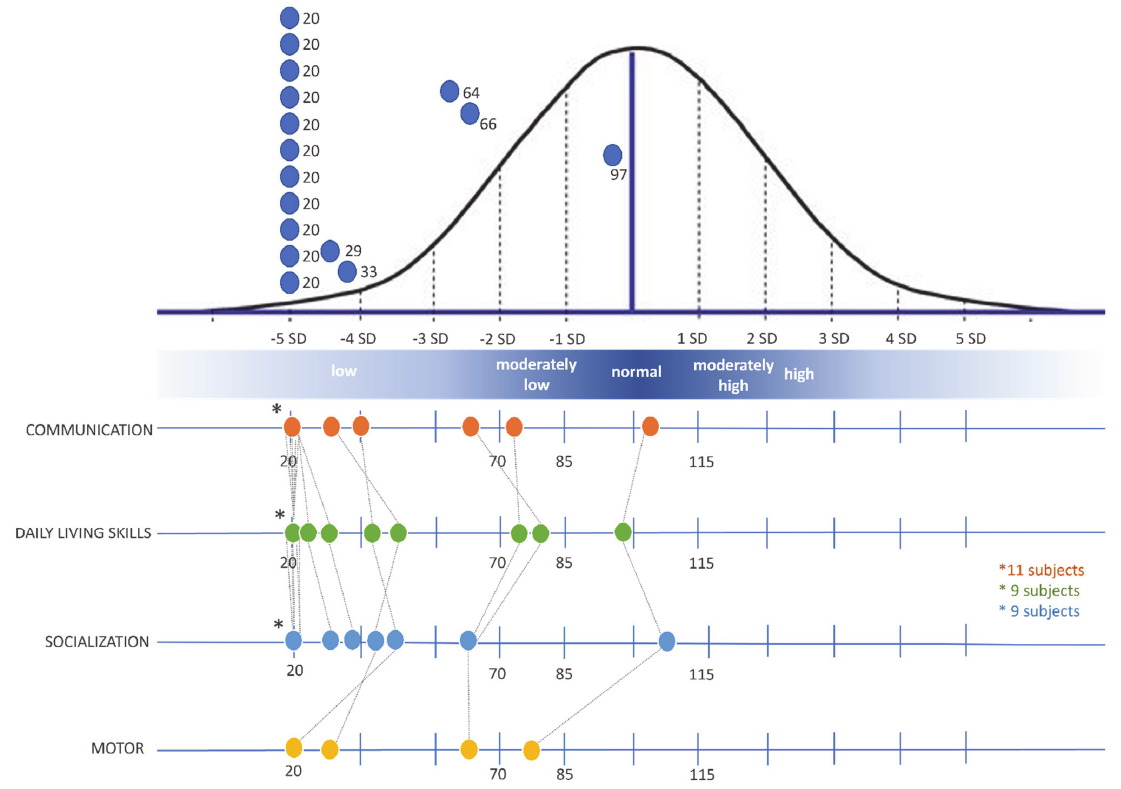
Figure 2. Distribution of Vineland-II ABC and subscales